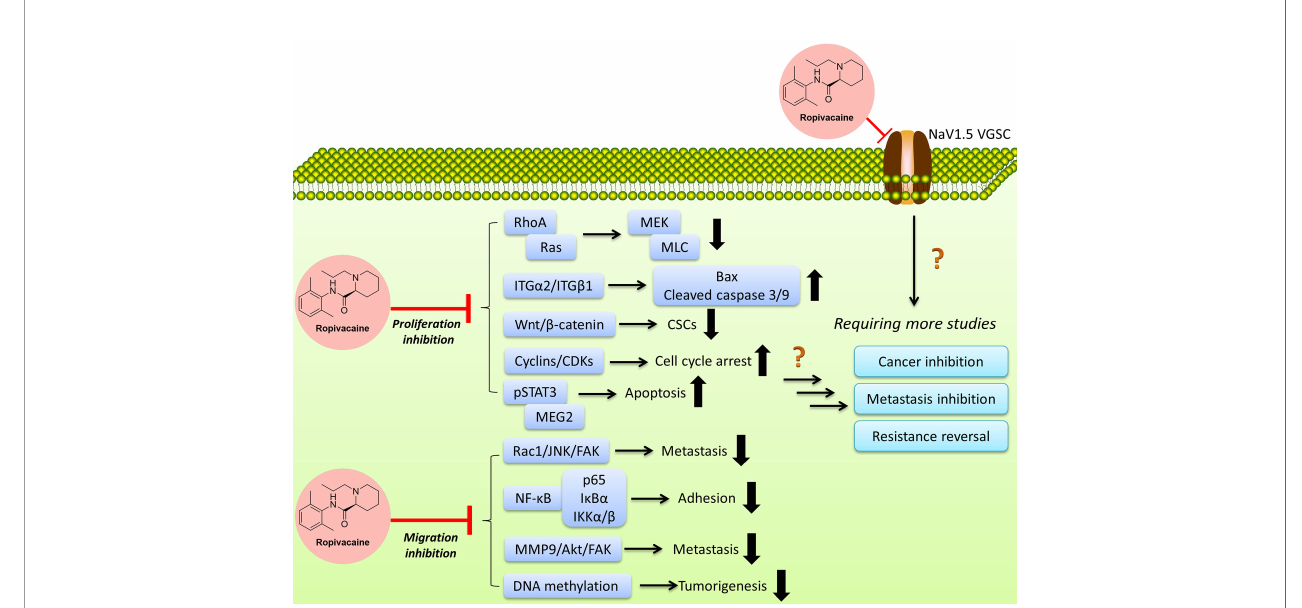
FIGURE 2 | Ropivacaine suppresses cancer cells via multiple targets/functions by modulating multiple signal pathways. More efforts are needed to reveal the full map of the